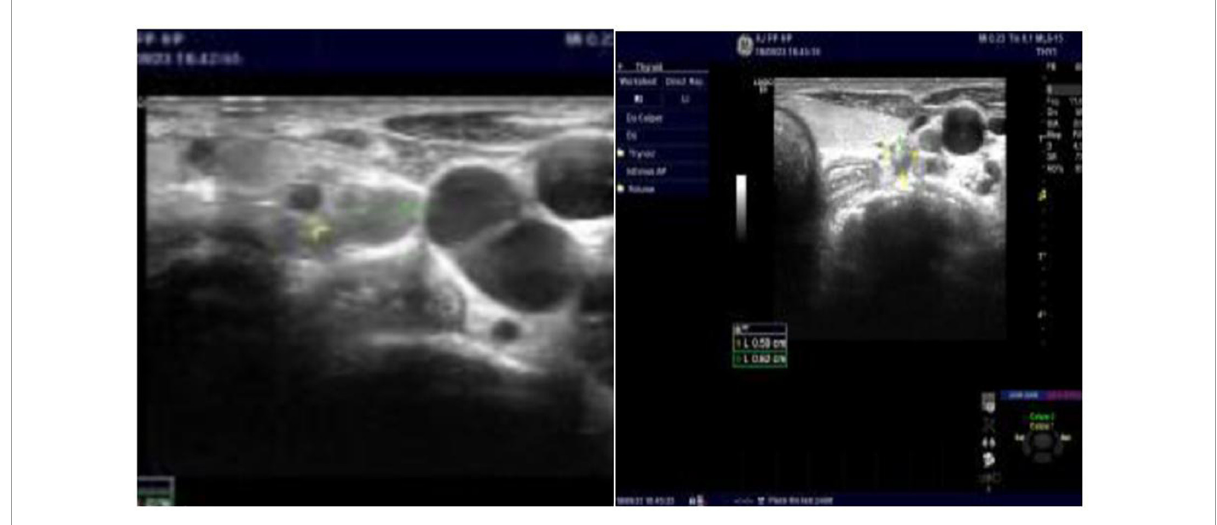
FIGURE1 B-ultrasound image before parathyroid radiofrequency